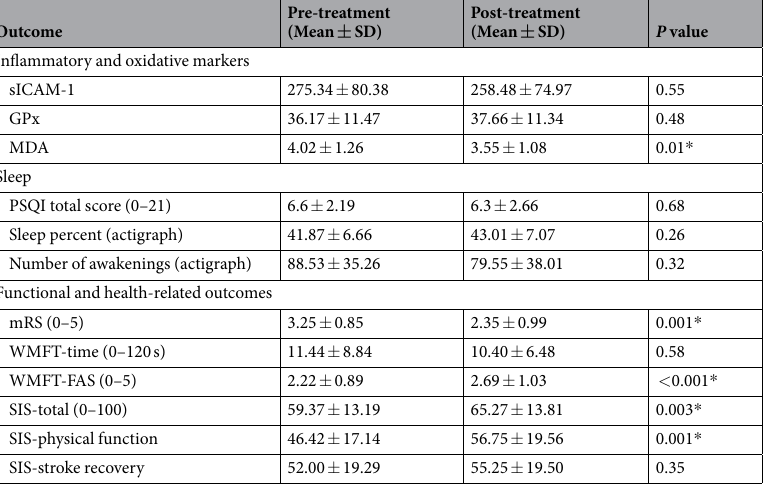
Table 3. Inflammation, oxidative stress levels, sleep and functional and health-related outcomes before and after treatment in patients with stroke (N = 20). sICAM-1 = Soluble intercellular adhesion molecule-1; GPx = Glutathione peroxidase; MDA = Malondialdehyde; PSQI = Pittsburg Sleep Quality Index; mRS = modified Rankin Scale; WMFT-time = performance time of the Wolf Motor Function Test; WMFT- FAS = functional ability scale of the Wolf Motor Function Test; SIS = Stroke Impact Scale; SD = standard deviation. * p <